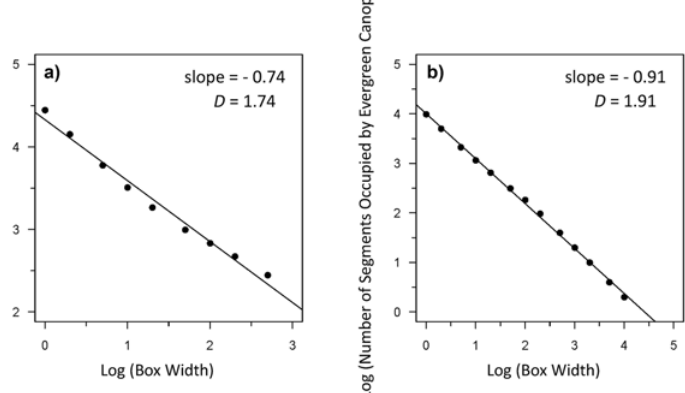
Figure 5. Example from Transect 1 of a log-log plot of the relationship between box width (scale) and the number of segments occupied by ( a ) buffaloberry (slope = − 0.74); and ( b ) evergreen canopy (slope = − 0.91) used to calculate the fractal dimension ( D ) of each. The slope of the regression line equals 1- D [47] for a given transect. The number of orders of magnitude across which the relationship is fractal-like can be determined based on the x ‐ intercept.